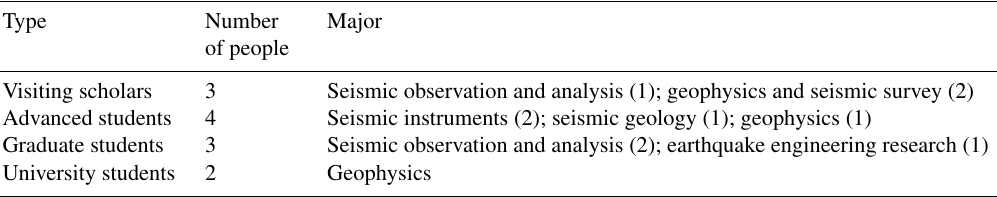
Table 3. List of people sent by IGCAS to the former Soviet Union for advanced studies between 1955 and 1956. (Source: Chinese Geophys- ical Society, 2012.) Type Number Major of people Visiting scholars 3 Seismic observation and analysis (1); geophysics and seismic survey (2) Advanced students 4 Seismic instruments (2); seismic geology (1); geophysics (1) Graduate students 3 Seismic observation and analysis (2); earthquake engineering research (1) University students 2